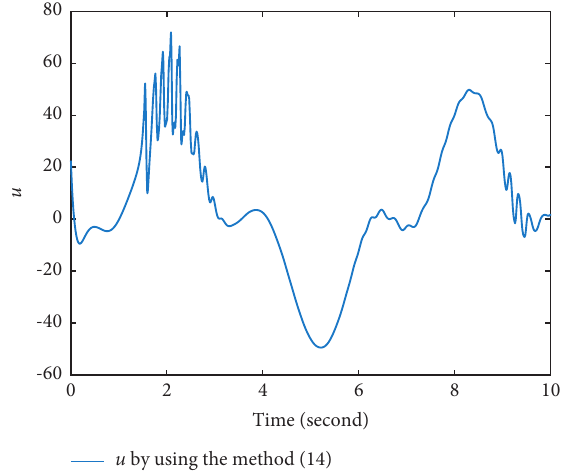
Figure 9: Time response trajectory of controller u by using method ( t ) (14) under ρ 2